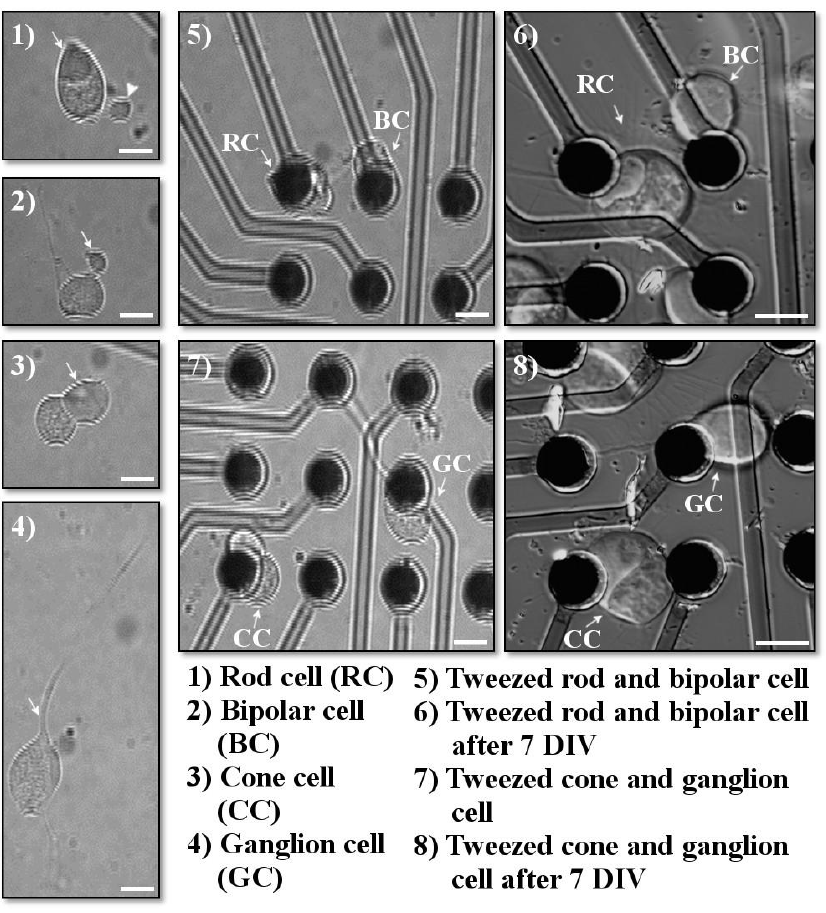
Figure 4. Examples of cells chosen for optical tweezing. Cells were imaged immediately prior to tweezing, immediately after tweezing, and after several days in vitro. ( 1 ) Arrow points to the triangular ellipsoid typical for rod cells; arrowhead points to the rod axon terminal. ( 2 ) Arrow indicates the bipolar Landolt club. ( 3 ) Arrow points to the spherical cone ellipsoid. ( 4 ) Arrow indicates the ganglionic primary dendrite. ( 5 – 8 ) Retinal cells after optical tweezing ( 5 , 7 ) immeditely after tweezing; ( 6 , 8 ) 7 days in vitro (DIV) after tweezing. Scale bars = 10 µm.